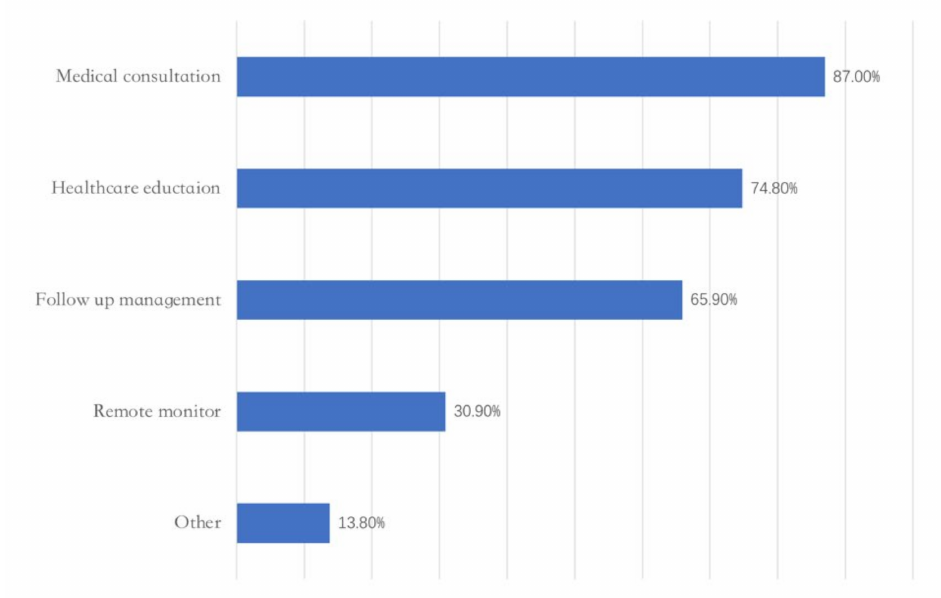
Figure 6. Non-core medical businesses. Adapted from source: National Telemedicine Center of China